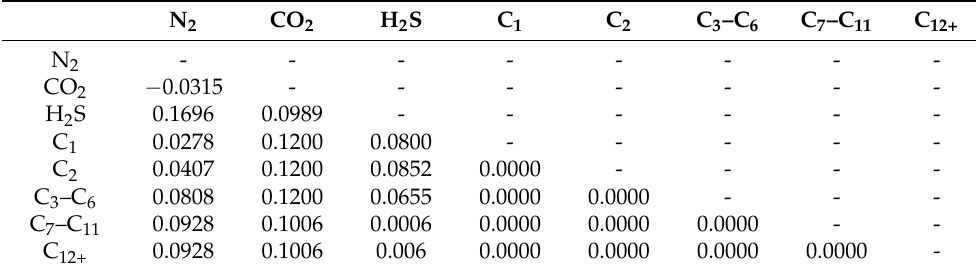
Table 5. Fluid model binary coefficients for the Soave–Redlich–Kwong (SRK) equation of state (EoS) model.